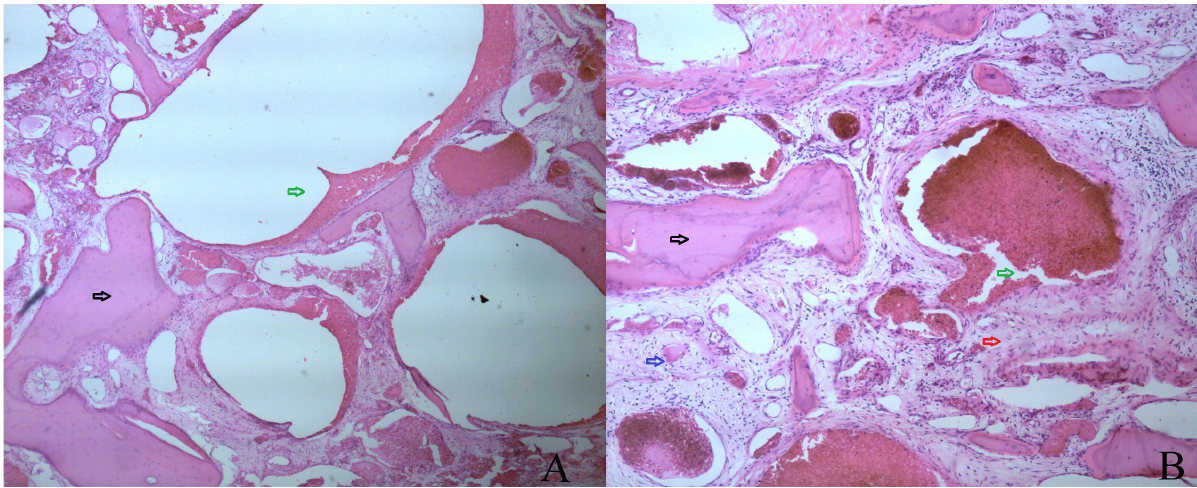
Figure 4: A Microscopic examination revealed thin walled and dilated blood vessels containing red blood cells and bone trabeculae (HE×100). B Microscopic examination revealed homogeneous conglomerate, irregular, thin walled and dilated blood vessels containing red blood cells, supported by fibrous stroma, and intermingled to regular bone trabeculae (HE×200).Green arrow: blood vessels containing red blood cells. Black arrow: bone trabeculae.Blue arrow: homogeneous conglomerate. Red arrow: fibrous